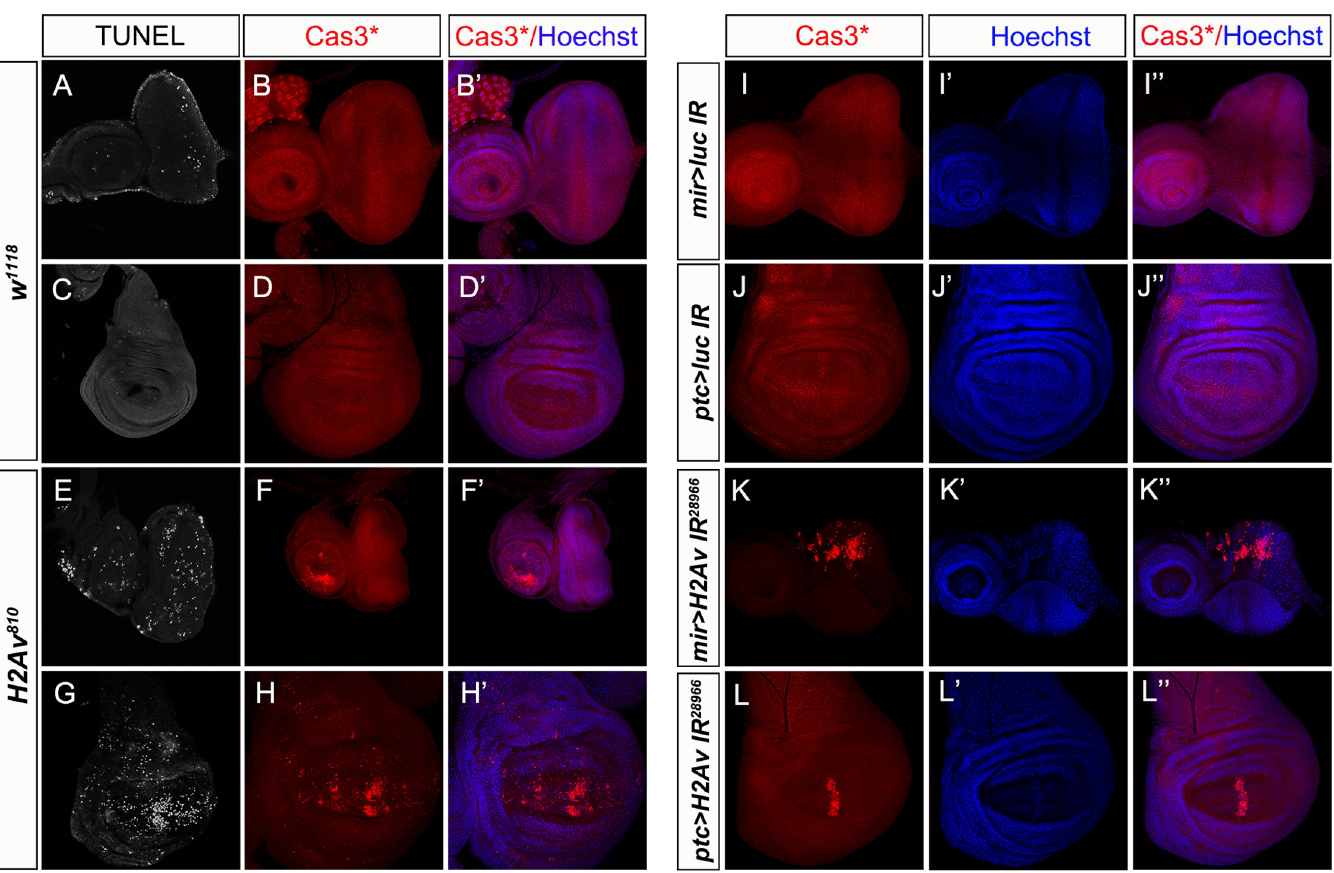
Fig 5. Loss of H2Av induces apoptosis in the eye and wing discs. (A-H’) H2Av deletion caused apoptosis in the eye and wing discs. (A and E) The TUNEL signals were increased in the homozygous H2Av 810 eye disc (E) compared with the control (A). (B-B’ and F-F’) The Cas3 � was activated in the antenna disc in the homozygous H2Av 810 (F-F’) compared with the control (B-B’). (C and G) The TUNEL signals were increased in the wing pouch in the homozygous H2Av 810 (G) compared with the control (C). (D-D’ and H-H’) The Cas3 � was activated in the wing pouch in the homozygous H2Av 810 (H) compared with the control (D). (I-L”) Knockdown of H2Av induced apoptosis in the eye and wing discs. (I-J”) The control eye and wing discs. (K-K”) Knockdown of H2Av by mirro-gal4 induced activation of Cas3 � in the dorsal compartment of the eye disc before MF. (L-L”) Knockdown of H2Av by ptc-gal4 induced activation of Cas3 � in the A/P boundary of the wing disc. Genotypes: A-D’: w 1118 ; E-H’: H2Av 810 /H2Av 810 ; I-I”: mirror-gal4/UAS-luciferase IR ; J-J”: ptc-gal4/+; UAS-luciferase IR/+ ; K-K”: mirror-gal4/UAS-H2Av IR 28966 ; L-L”: ptc-gal4/+; UAS-H2Av IR 28966 /+